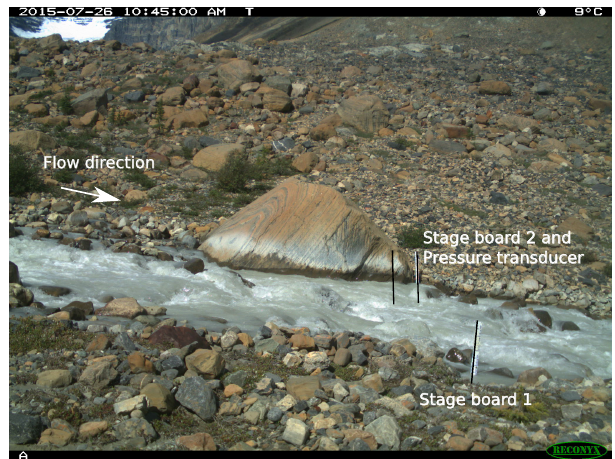
Figure 3. Reconyx raw picture showing the installation of stage boards, pressure transducer and boulder used for gauging (centre of picture). Black lines represent the three different tested